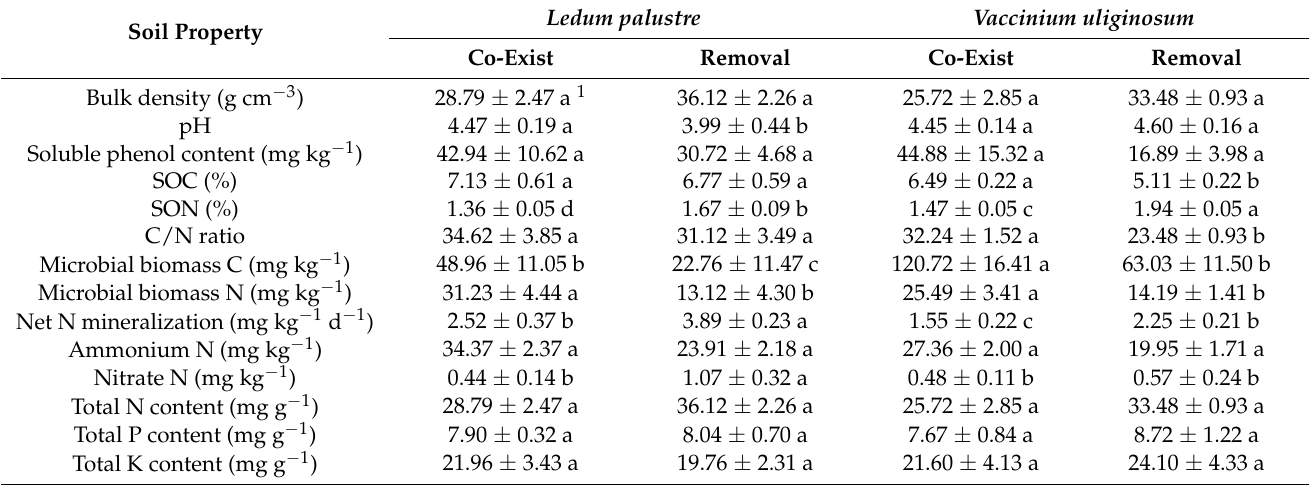
Table 2. Effects of combined dominant species ( Ledum palustre vs. Vaccinium uliginosum ) of understory communities and the interruption of removal on soil properties in forests of northeast